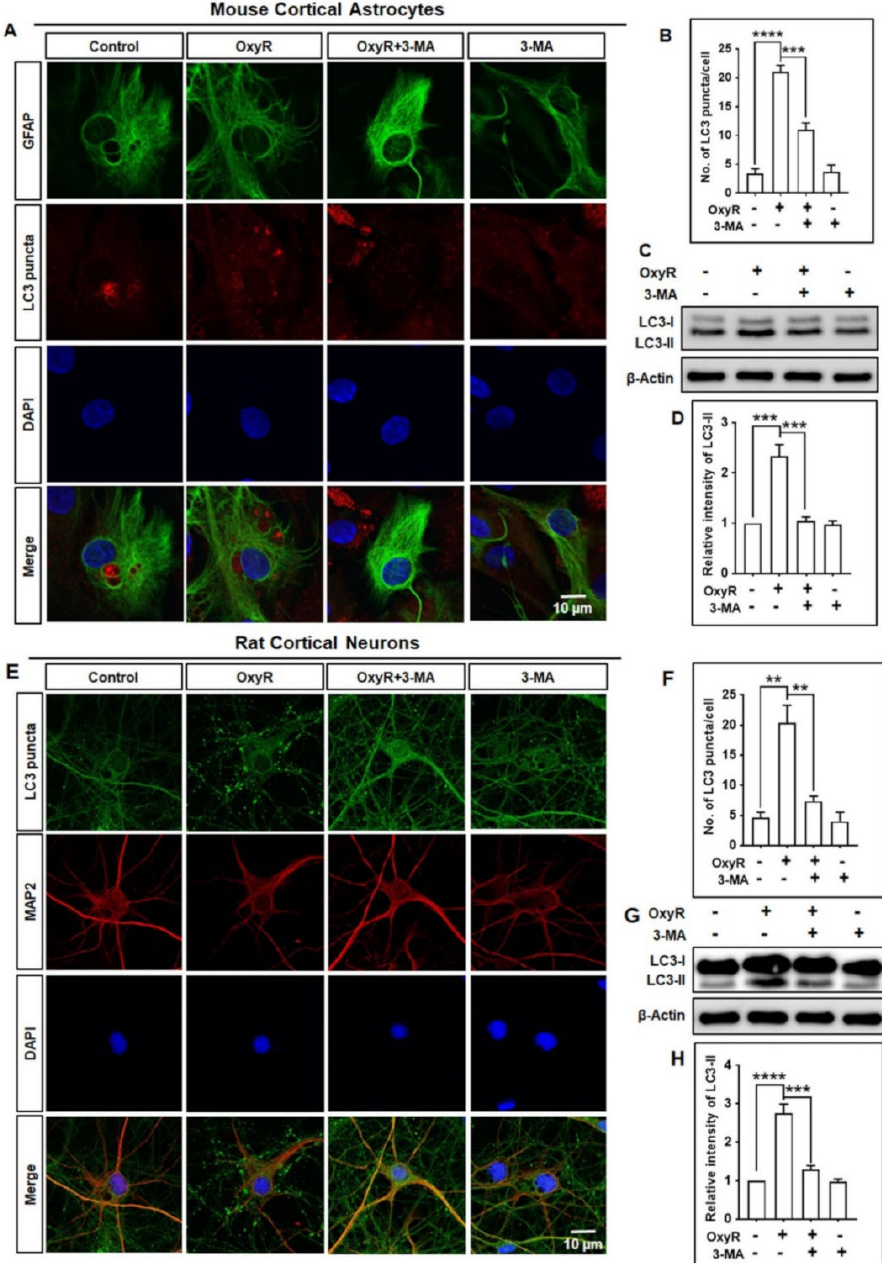
Figure 2. The autophagy inhibitor 3-MA blocked OxyR-mediated autophagy in cortical astrocytes and neurons. ( A , E ) Astrocytes and neurons were pretreated with 3-MA (2.5 mM) for 3 h, and LC3 puncta were visualized by immunofluorescence staining with anti-GFAP (green), anti-MAP2 (red), and anti-LC3 (red) antibodies under a confocal microscope. ( B , F ) LC3 puncta formation was determined from at least 3 randomly selected independent areas on each slide; the puncta of at least 5 cells were counted. ( C , G ) Astrocytes and neurons were pretreated with 3-MA for 3 h; OxyR treatment included incubation with 10 µ M OxyR for 24 h. Representative LC3 levels were determined by immunoblotting analysis. ( D , H ) Western blot band intensities were measured by using ImageJ software, and each expression was normalized to that of β -actin. Statistical analysis was performed by one-way ANOVA ( n = 3). Data are presented as mean ± SEM. ** p < 0.01, *** p < 0.001, **** p < 0.0001. OxyR, oxyresveratrol; 3-MA, 3-methyladenine; GFAP, glial fibrillary acidic protein; MAP2, microtubule-associated protein 2; DAPI, the nuclear marker 4 (cid:48) ,6-diamidino-2-phenylindole; LC3, microtubule-associated protein light chain